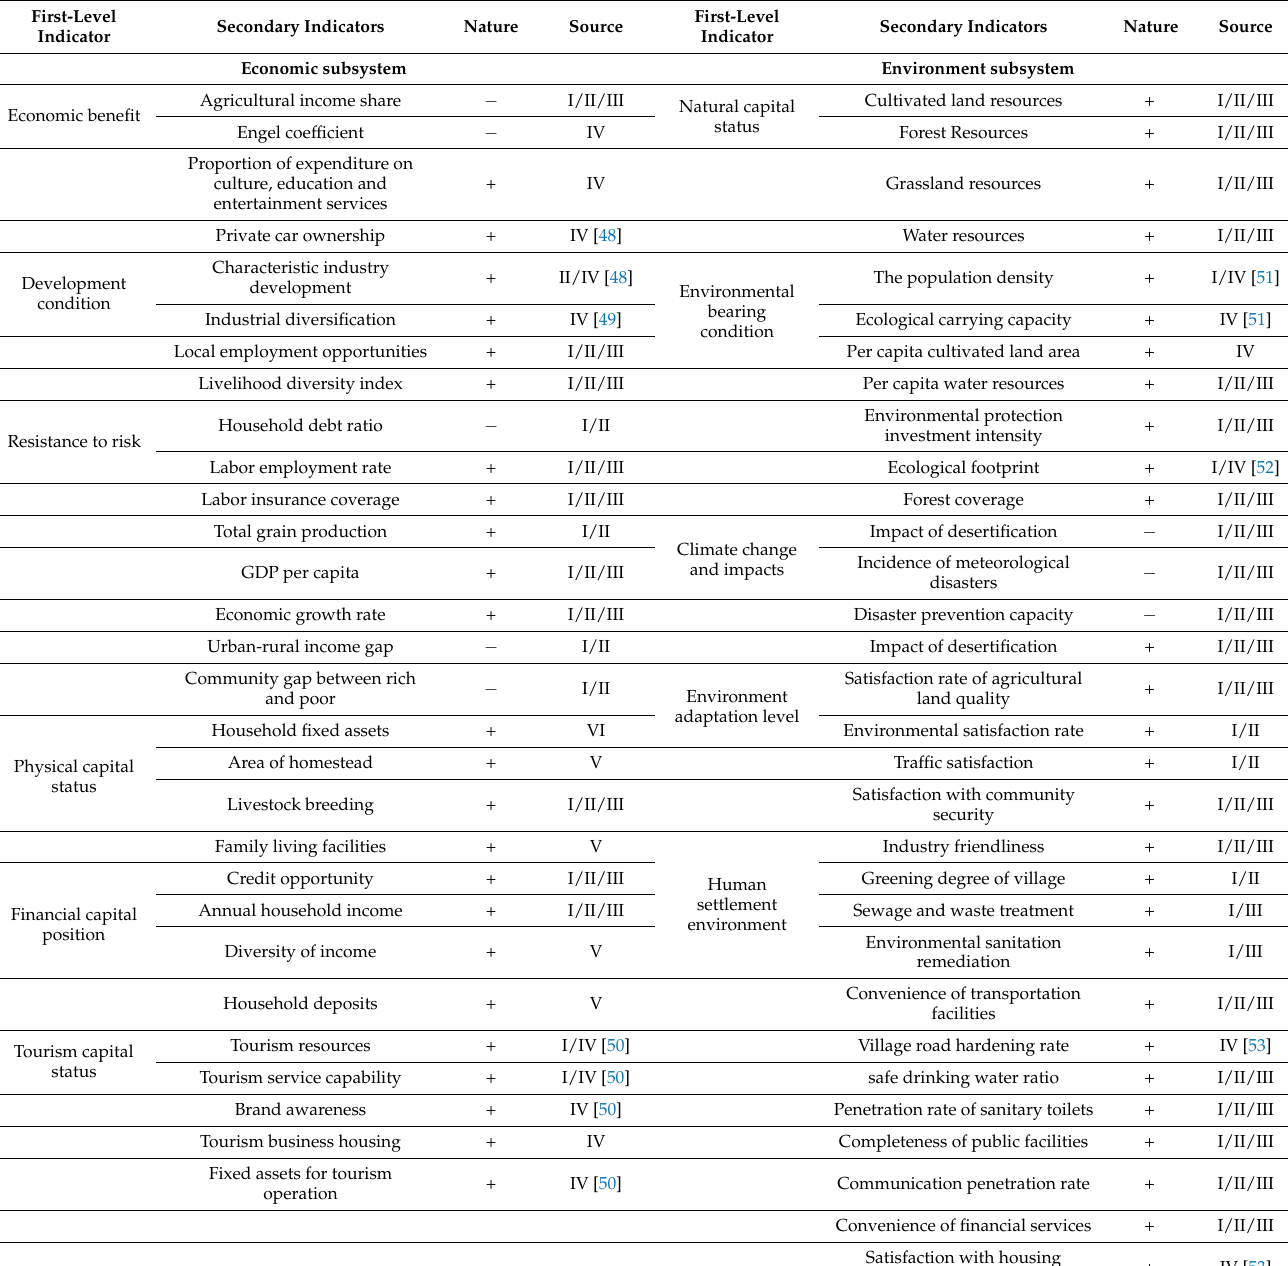
Table 1. Primary indicator system for sustainable livelihood of farmers in the ecological resettlement area of the Yellow River basin